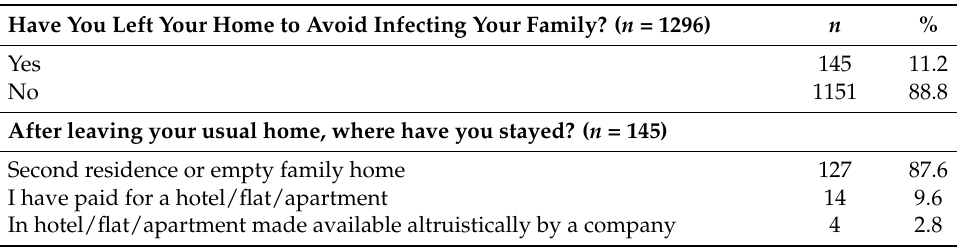
Table 4. Changes in nurses’ personal lives due to the COVID-19